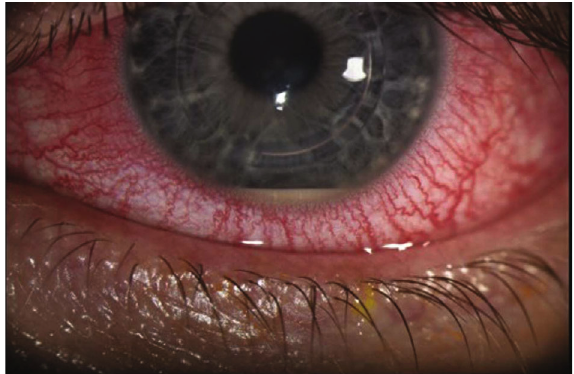
Figure 1: Slit beam photograph of the left eye. This photograph demonstrates 2+ perilimbal injection and 1-1.5 mm inferior hypopyon observed at the time of initial presentation. There is no overlying epithelial defect or appreciable in fi ltrate in the cornea. Both intrastromal corneal ring segments are in